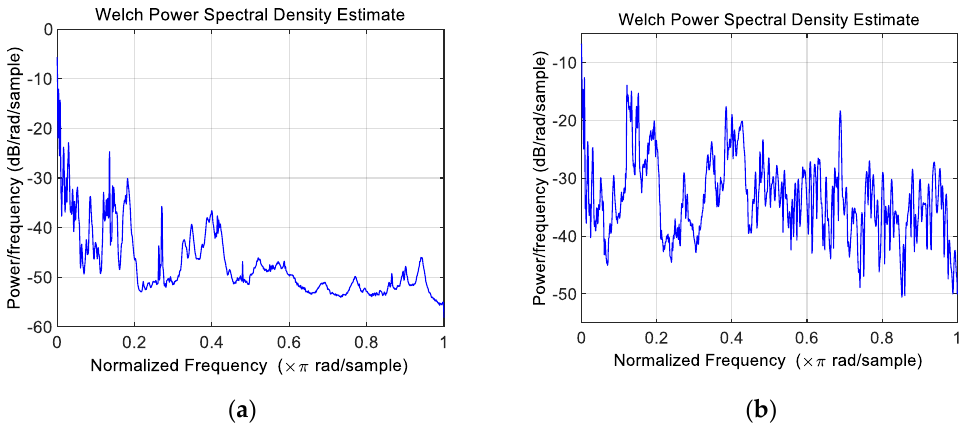
Figure 8. Comparison of normal and faulty data. ( a ) Normal PSD Hanning window (length 2048); ( b ) faulty PSD data Hanning window (length 2048).